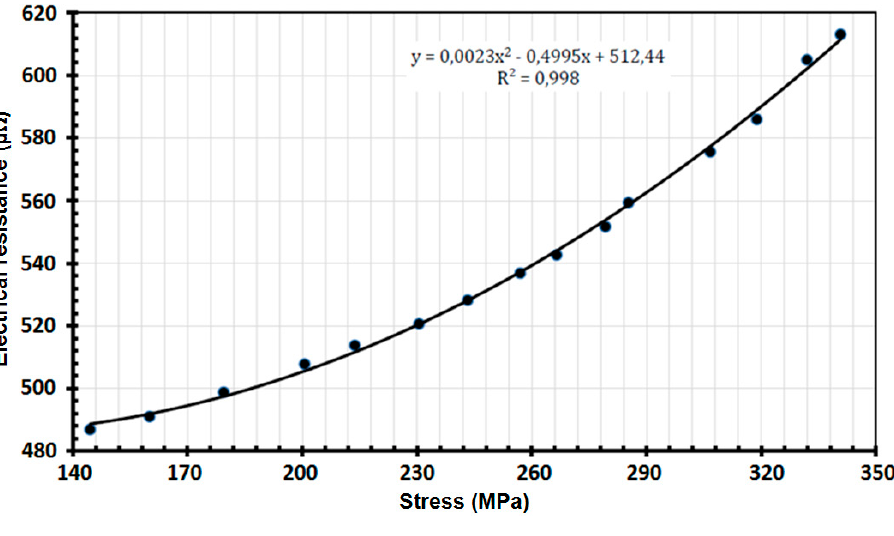
Figure 12. Electrical resistance in function of mechanical